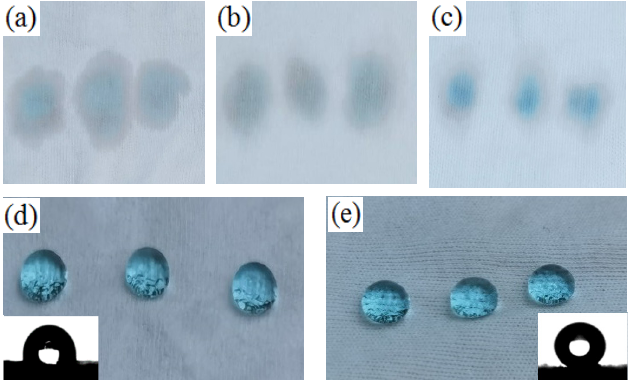
Figure 6. Pictures of water droplets on the surfaces of the ( a ) pure cotton fabric, ( b ) B cotton fabric, ( c ) BA cotton fabric, ( d ) BAP cotton fabric (including its droplet image) and ( e ) BAPC cotton fabric (including its droplet image).